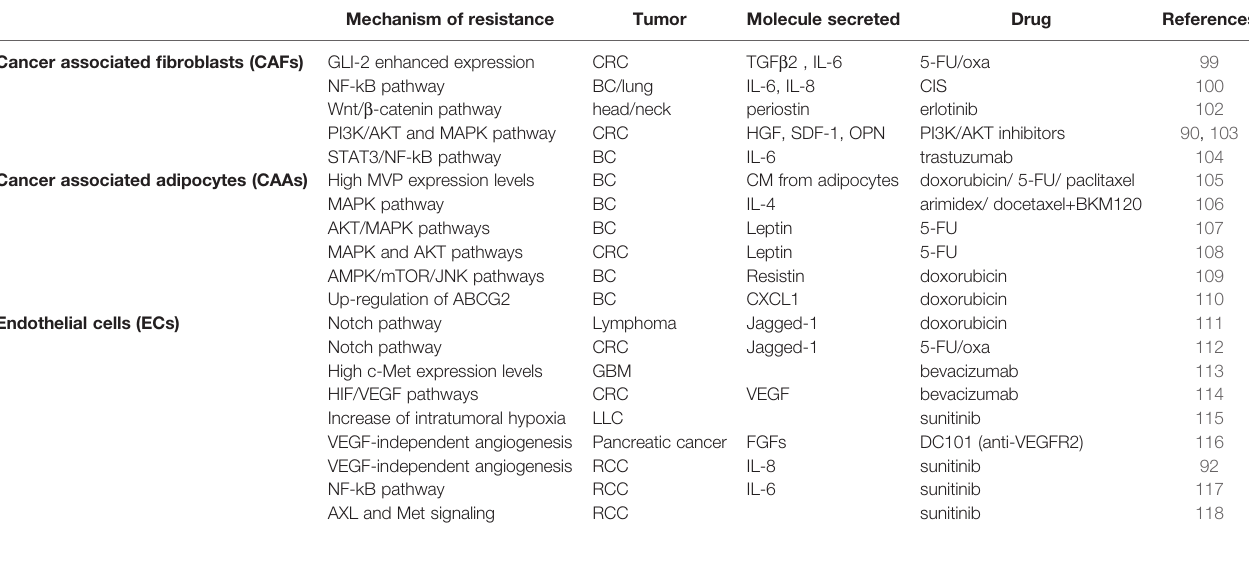
TABLE 2 | Molecular mechanisms prompting cancer stem cell resistance to standard and targeted